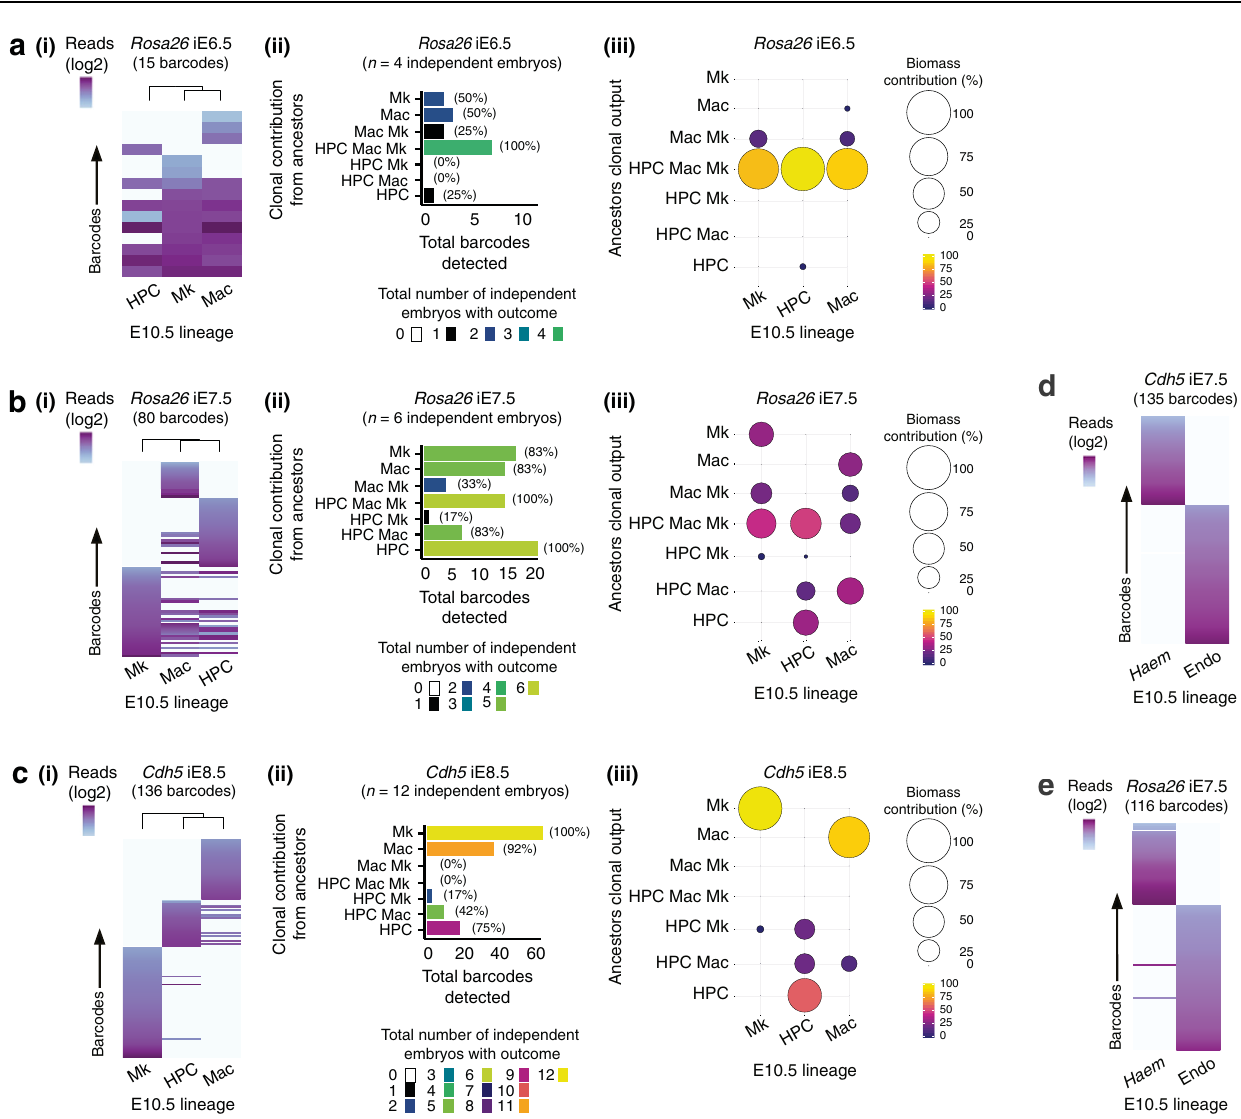
barcodes [77 barcodes]). c Induction of barcode formation at E8.5 induction using Cdh5 iCre (136 barcodes, n =12 embryos).(i) Heatmaps of all informative barcodes. (ii) Biological reproducibility of clonal outcomes. Colours represent the total number of independent embryos with the stated clonal outcome. Values in par- entheses represent the percentage of independent embryos in which the clonal outcome was observed. (iii) Summary of contribution to the E10.5 yolk sac non- erythroid haematopoietic lineages biomass (based on 5 – 9 element barcodes [109 barcodes]). d Barcode distribution between the E10.5 yolk sac endothelial (Endo) and non-erythroid haematopoietic ( Haem ) lineages after Cdh5 iCre induction at E7.5.135 informative barcodes, n =6 independent embryos. e Barcode distribution between the E10.5 yolk sac endothelial (Endo) and non-erythroid haematopoietic ( Haem ) lineages after Rosa26 iCre induction at E7.5.116 informative barcodes, n =3 independent